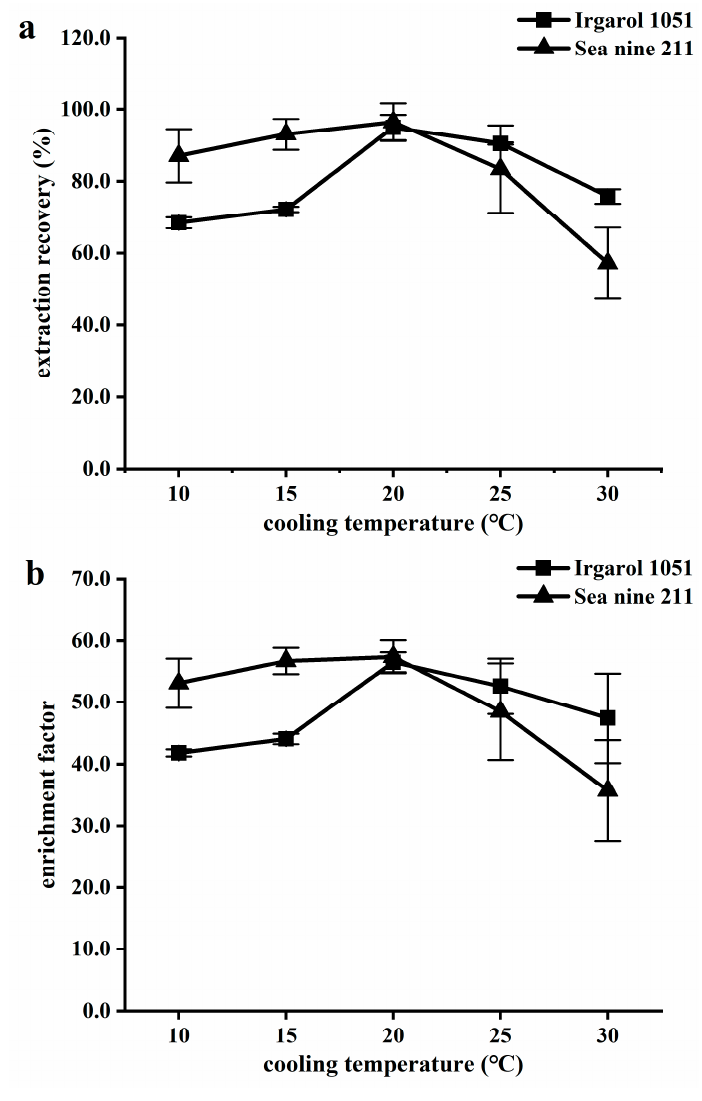
Figure 5. Influence of cooling temperature on ( a ) extraction recovery and ( b ) enrichment Figure 5. In fl uence of cooling temperature on ( a ) extraction recovery and ( b ) enrichment factor. Ex- traction conditions: water sample, 5.0 mL; disperser solvent, ethyl acetate 0.4 mL; extraction solvent [HMIm][PF6] 60 mg; NaCl 0% ( w / v ); and pH 6.